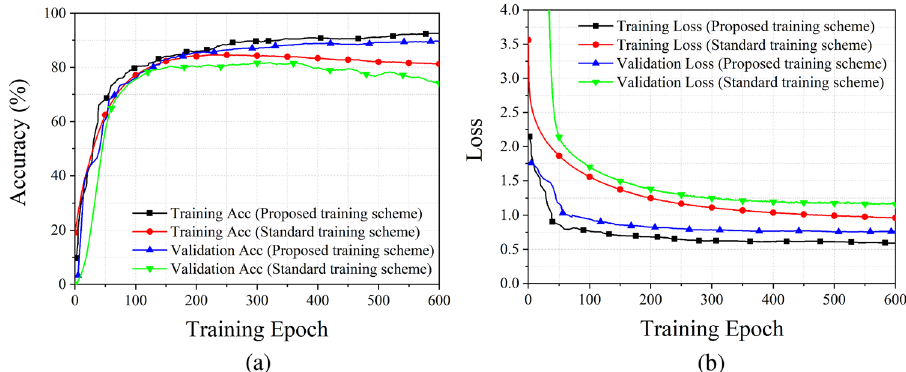
Figure 4. Training performance of the proposed method and standard training scheme. ( a ) Training and validation accuracy, ( b ) training and validation loss.